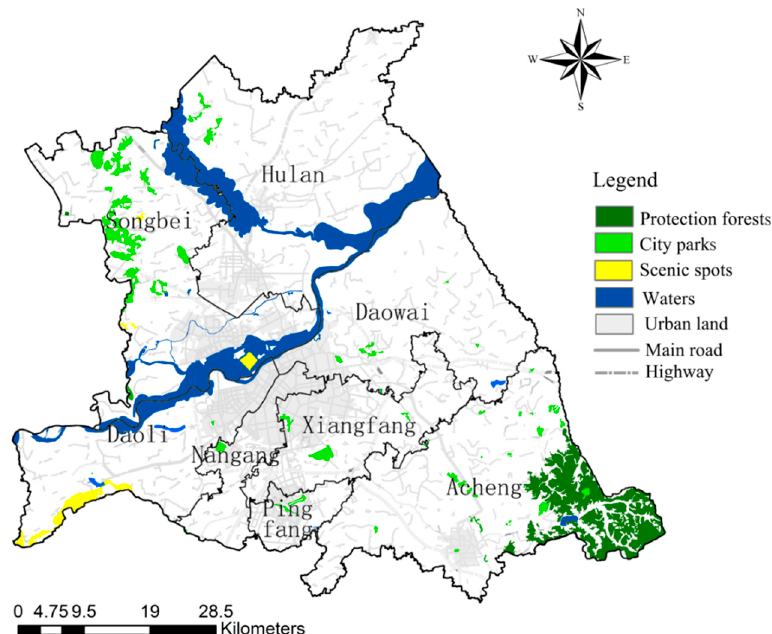
Figure 2. Spatial distribution of ecological elements in the study area.